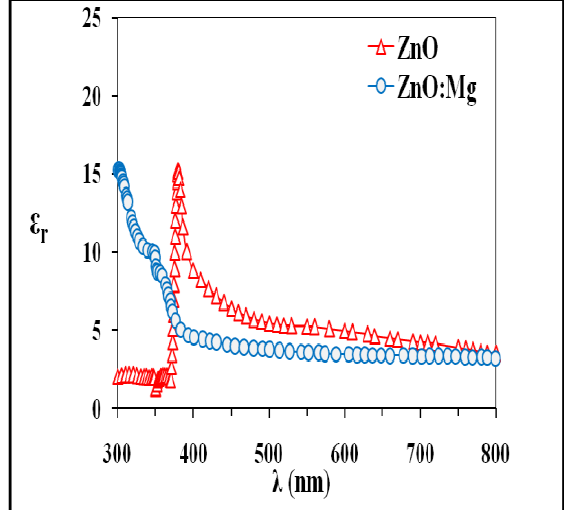
as a function of λ for ZnO r